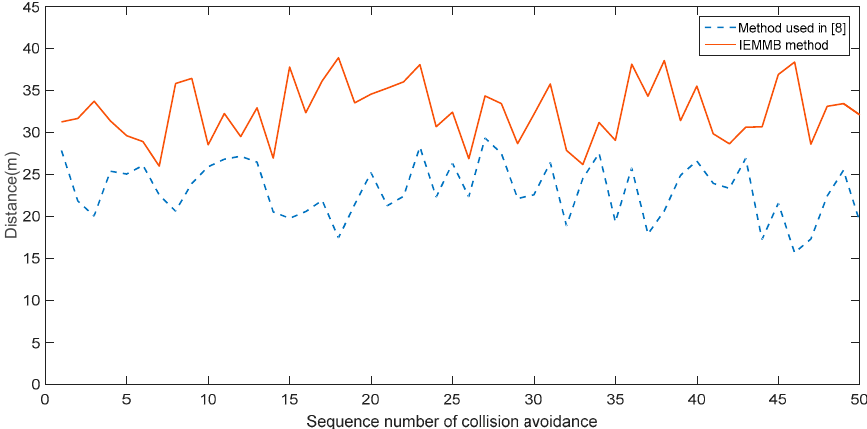
Figure 13. Collision detection distance on straight roads. The detection distance of the intent-estimation- and motion-model-based (IEMMB) method on a straight road is longer than the method used in [8].